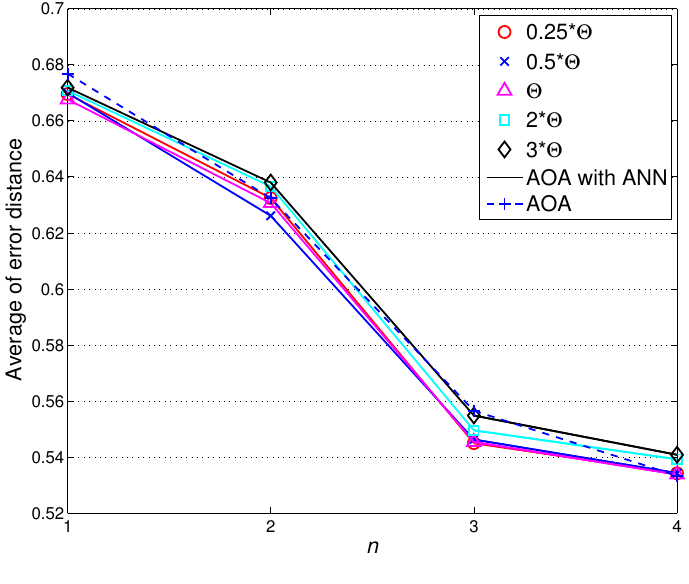
Figure 13. The comparison of target localization error with/without ANN refinement.